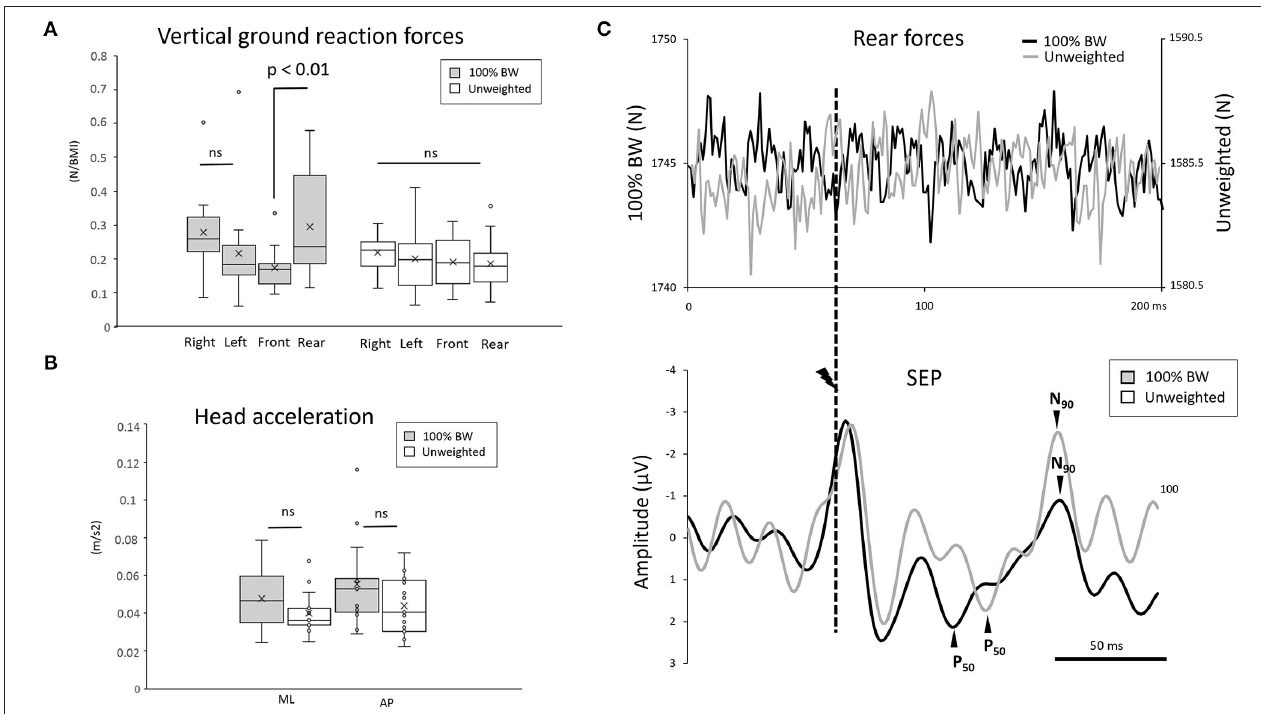
FIGURE 2 | (A) Whisker plot of the mean vertical ground reaction force during 100% BW and unweighted conditions in the 2 directions (mediolateral and anteroposterior) for all participants (error bars are standard error across participants) during a 3s period encompassing the whole stimulation in the standing task. (B) Whisker plot of the mean head acceleration during 100% BW and unweighted conditions in the 4 directions (forward, backward, right, and left) for all participants (error bars are standard error across participants) during a 3-s period encompassing the whole stimulation in the standing task. (C) Average of the rear forces and of the somatosensory evoked potential (SEP) in the 100% BW and unweighted conditions for a representative participant. The SEP was synchronized to the electric stimulation (dashed line). The deflection observed in the SEP curve at the moment of the stimulation corresponds to the electrical stimulation